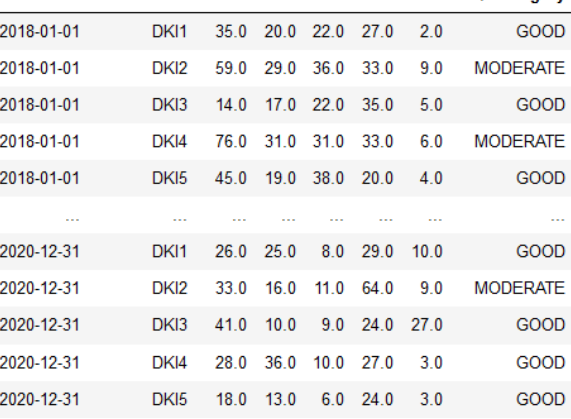
Figure 1. An illustration of the dataset we used in this study.